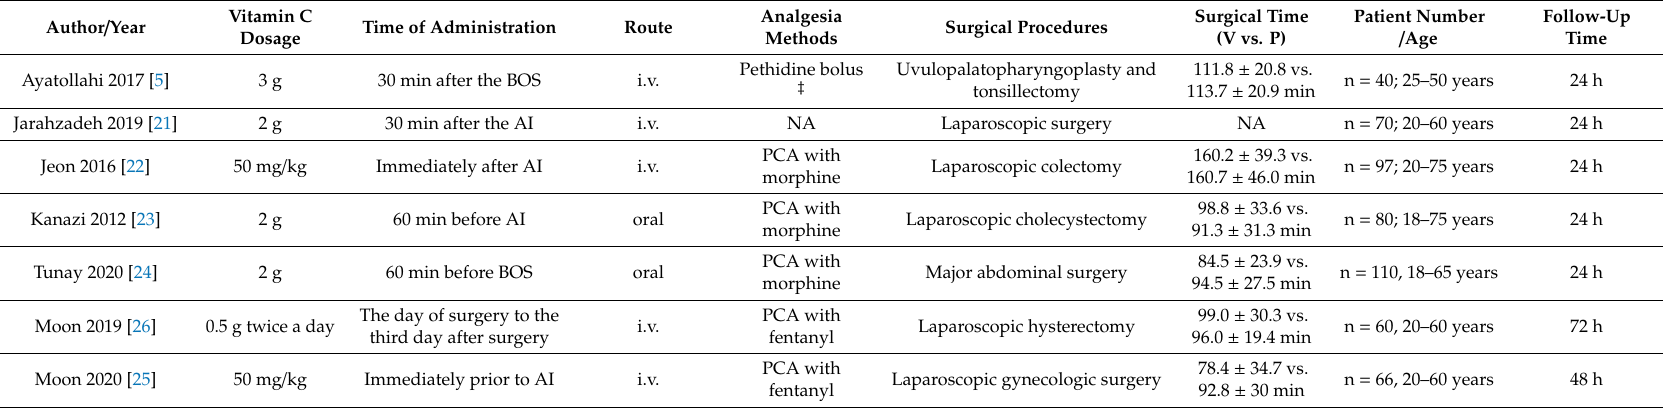
Table 1. Characteristics of the included